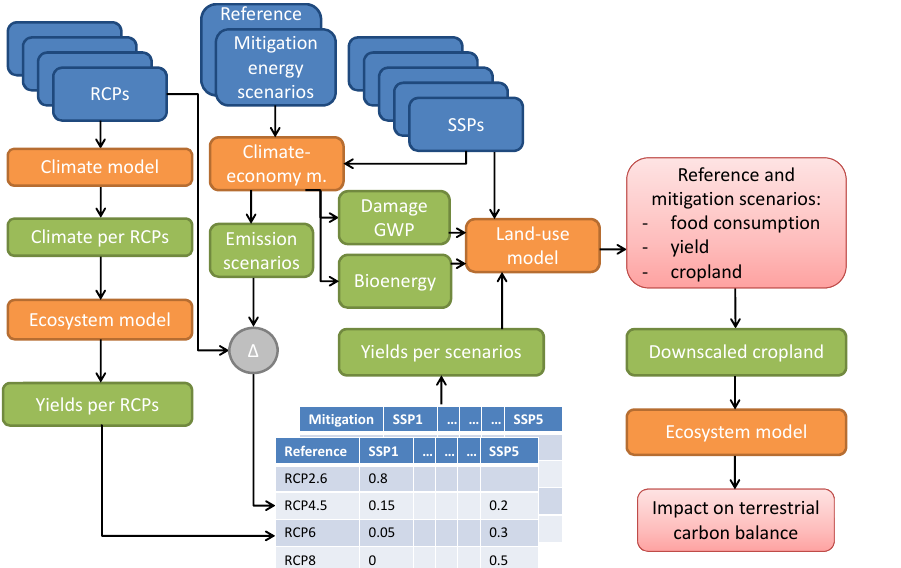
Figure 2. Overview of the novel integrated assessment modelling (IAM) framework showing input data sets in blue, component models in orange and information flows/intermediate results in green. Final results are displayed in red. The representative concentration path- ways (RCPs) are input to the climate model and the shared socio-economic pathways (SSPs) are input to the climate–economy model and the land use model. Damage to gross world product (GWP) is input to the land use model. (cid:49) signifies the distances between emissions predicted by the climate–economy model and implied by RCPs, used as inverse weights to create yield time series as input to the land use